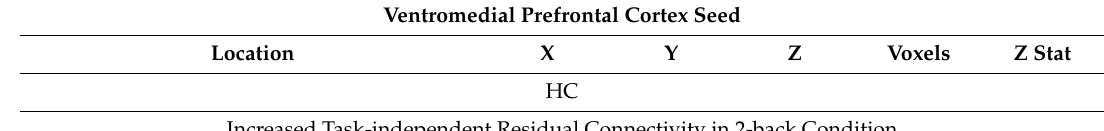
Table 4. Task-independent (residual) fatigue-related functional connectivity with the ventromedial prefrontal cortex as